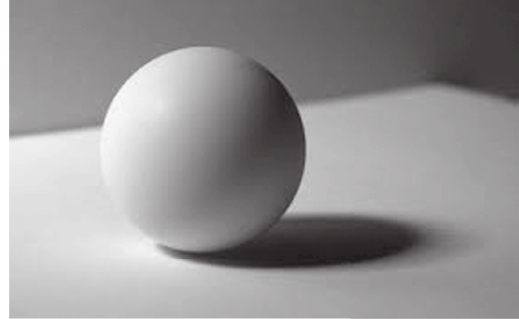
Figure 5. Shadow of a sphere